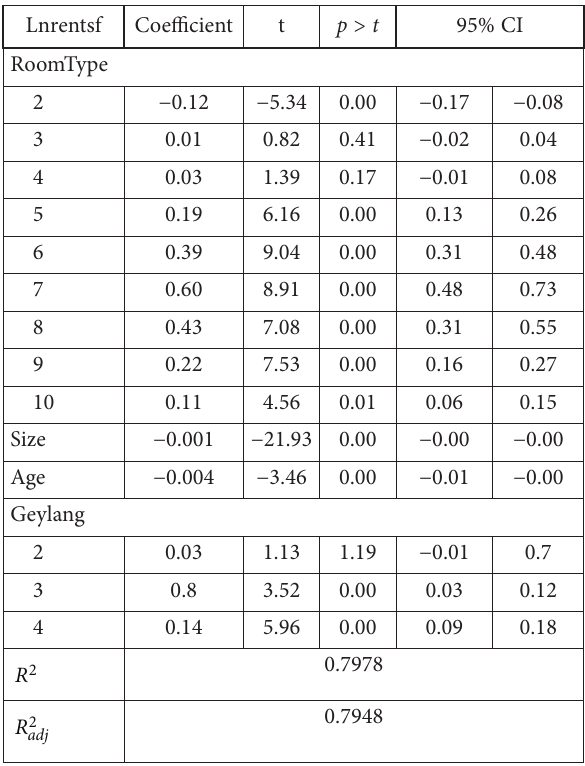
Table 4. Market rental price per square foot for 941 apartments: basic